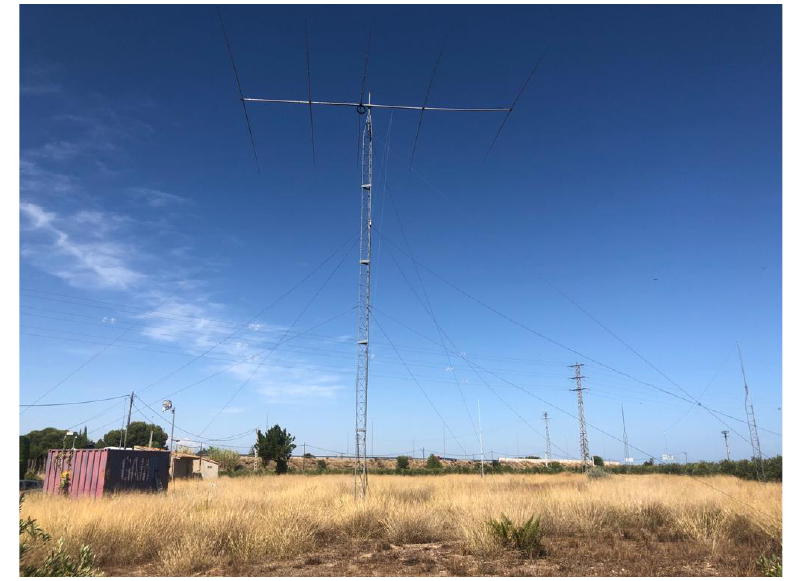
Figure 3. Receiver node in Cambrils (Spain).